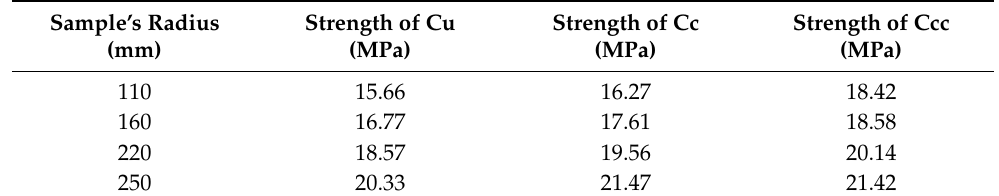
Table 11. The results of the numerical analysis.